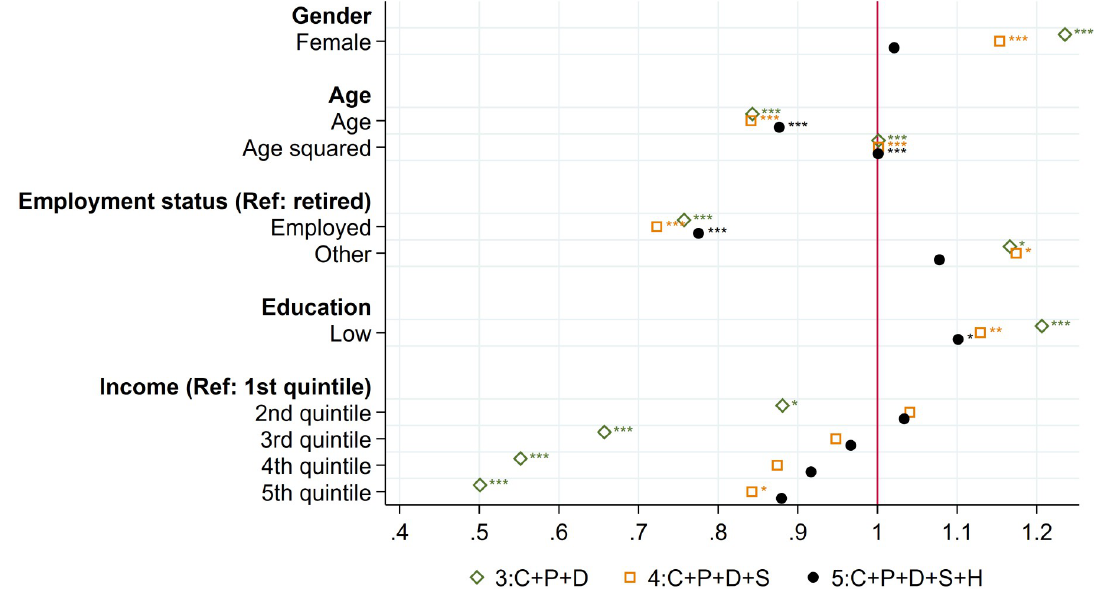
Fig 3. Loneliness at 50+: The role of demographic and socioeconomic factors. Note: The figure displays odds ratios of individual socioeconomic and demographic variables at age 50+ for three different specifications. Specification (3) includes D, a set of individual socioeconomic and demographic variables at age 50+; P, a vector of the five scores of personality traits (extraversion, agreeableness, conscientiousness, neuroticism, openness); C, a vector of childhood circumstances (wealth; health; quality of the relationship with mother, father, and friends; importance of religion), and I, country-specific fixed effects. Specification (4) includes (3) and S, social support, activities, and network variables at age 50+. Specification (5) includes (4) and H, a vector of individual health information at age 50+. Reading example: in the full specification, being employed decreases the odds of loneliness by 0.23. The pseudo R 2 and the proportion of correctly specified outcomes are respectively for each specification: (1): 0.0364; 82.89%, (2): 0.0600; 82.99%, (3): 0.0864; 82.96%; (4): 0.1181; 83.39%, (5): 0.1699; 84.09%. � p < 0.05, �� p < 0.01, ��� p < 0.001.